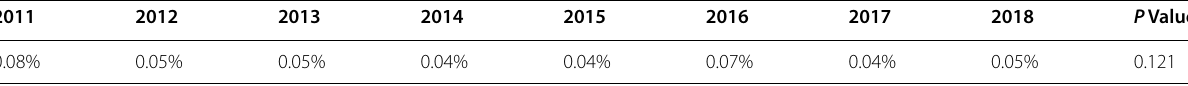
Table 2 Patient characteristics comparing those with and without acute kidney injury No Acute Kidney